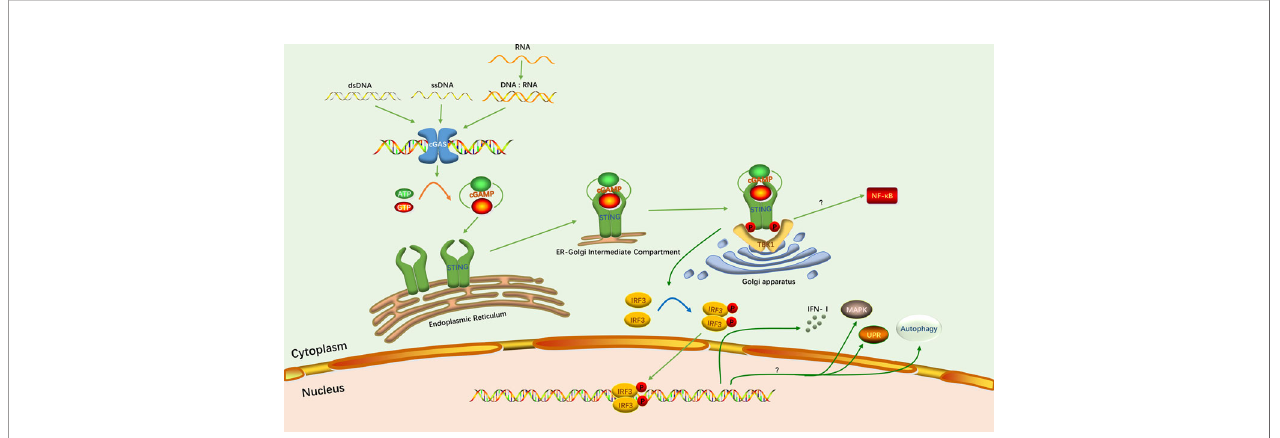
FIGURE 1 | The classical cGAS-STING signaling pathway. The green arrows indicate the activation of this pathway and induction of the IFN-I response. The yellow arrow indicates the synthesis of cGAMP. The blue arrow indicates the phosphorylation of IRF3. Protein phosphorylation is depicted as P. The question mark indicates that the speci fi c mechanism has not been